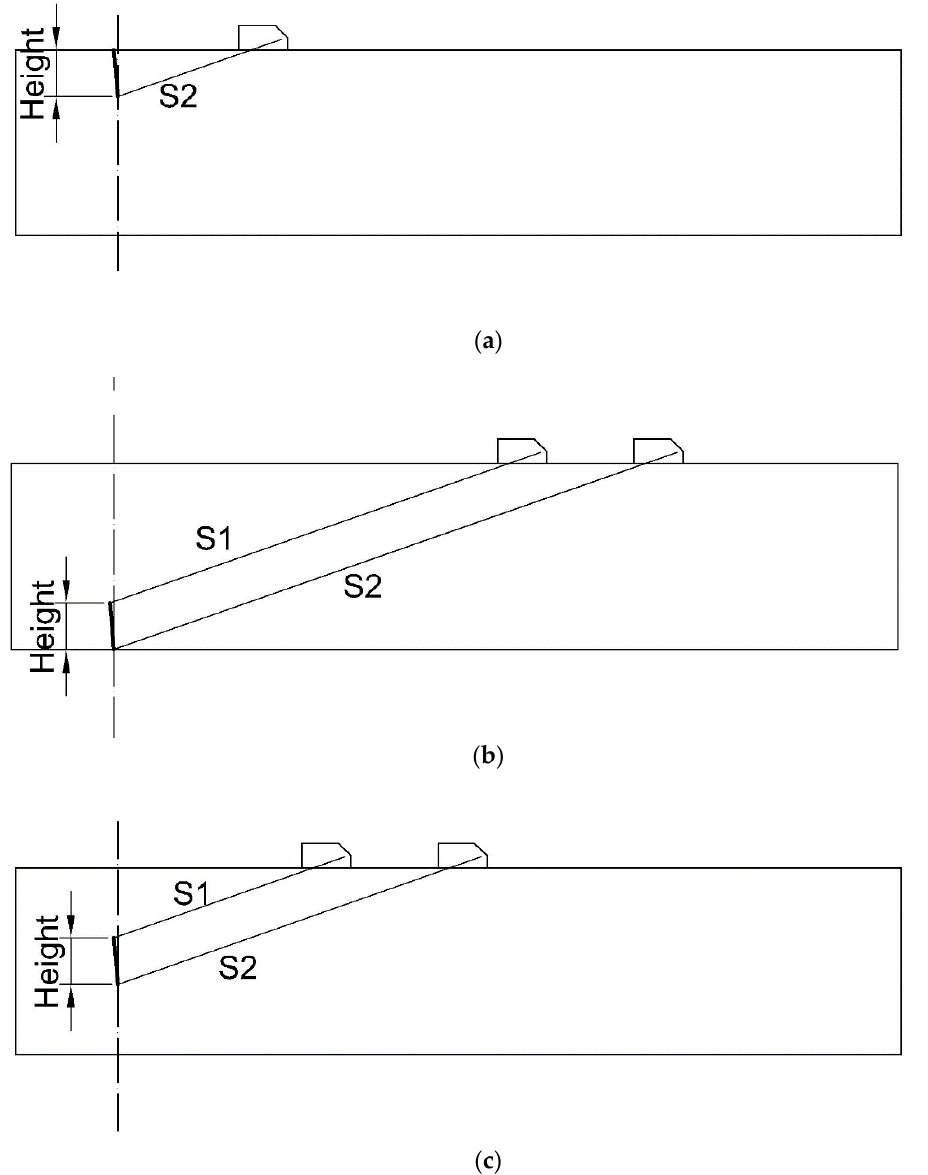
Figure 4. Measure flaw height of ( a ) top-surface connected flaws (TSCF), ( b ) bottom-surface connected flaws (BSCF) and ( c ) embedded flaws (EF).